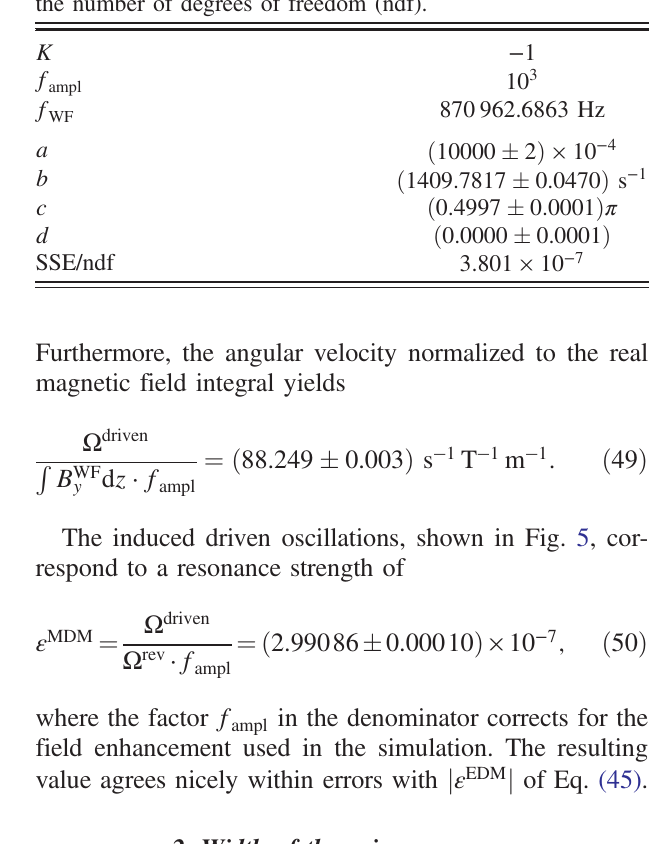
TABLE III. Result of the fit of the driven oscillation on resonance for K ¼ − 1 , shown in Fig. 5, using 10 000 turns with 101 data points. The other four cases K ¼ 0 , þ 1 , and (cid:4) 2 , within the given precision, yield identical values. SSE = ndf denotes the sum of squared deviations, computed using Eq. (47), divided by the number of degrees of freedom